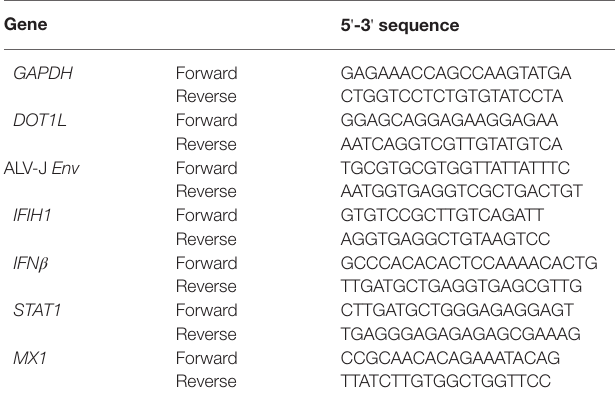
TABLE 2 | Primers used in